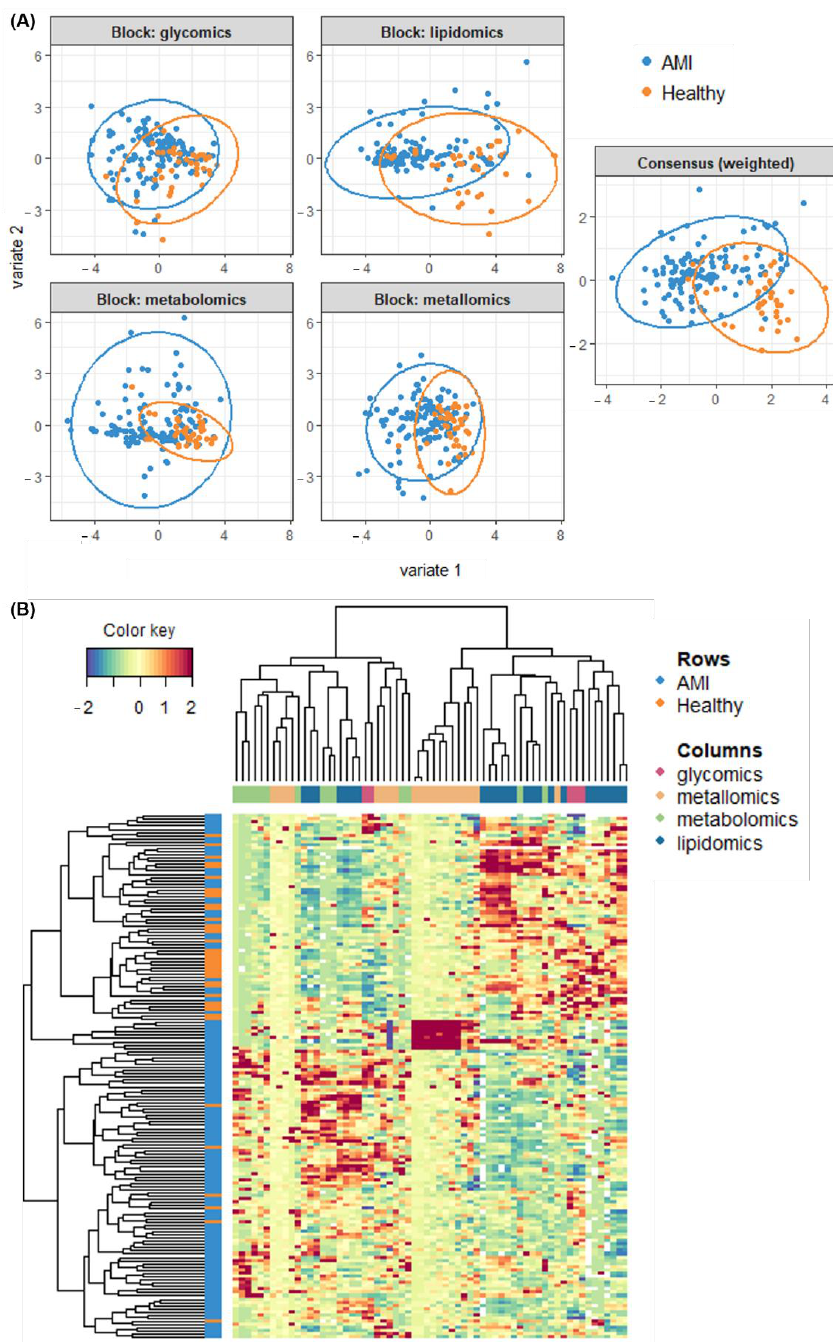
Figure 6. Classification performance of glycomics, metallomics, metabolomics and lipidomics datasets as shown from ( A ) block-PLS-DA analysis and comparison of individual blocks with a consensus multi-omics model, and ( B ) hierarchical cluster analysis of the multi-omics dataset.